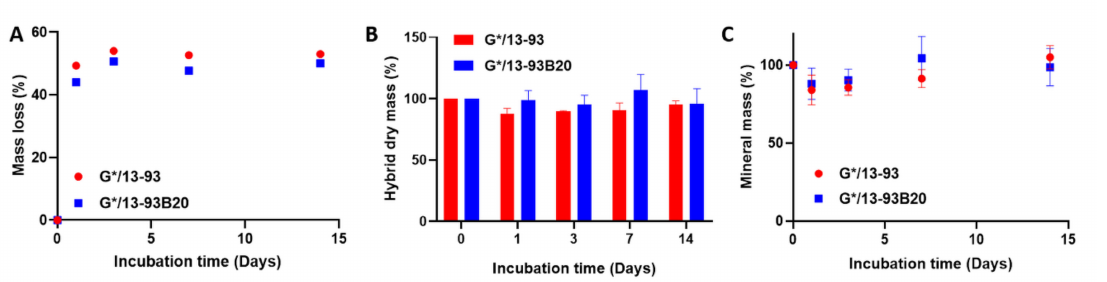
Figure 7. Mass loss ( A ), dry mass ( B ) and mineral mass ( C ) remained in the hybrid G*/13-93 ( • ) and G*/13-93B20 ( (cid:4) ) as a function of immersion time in SBF.